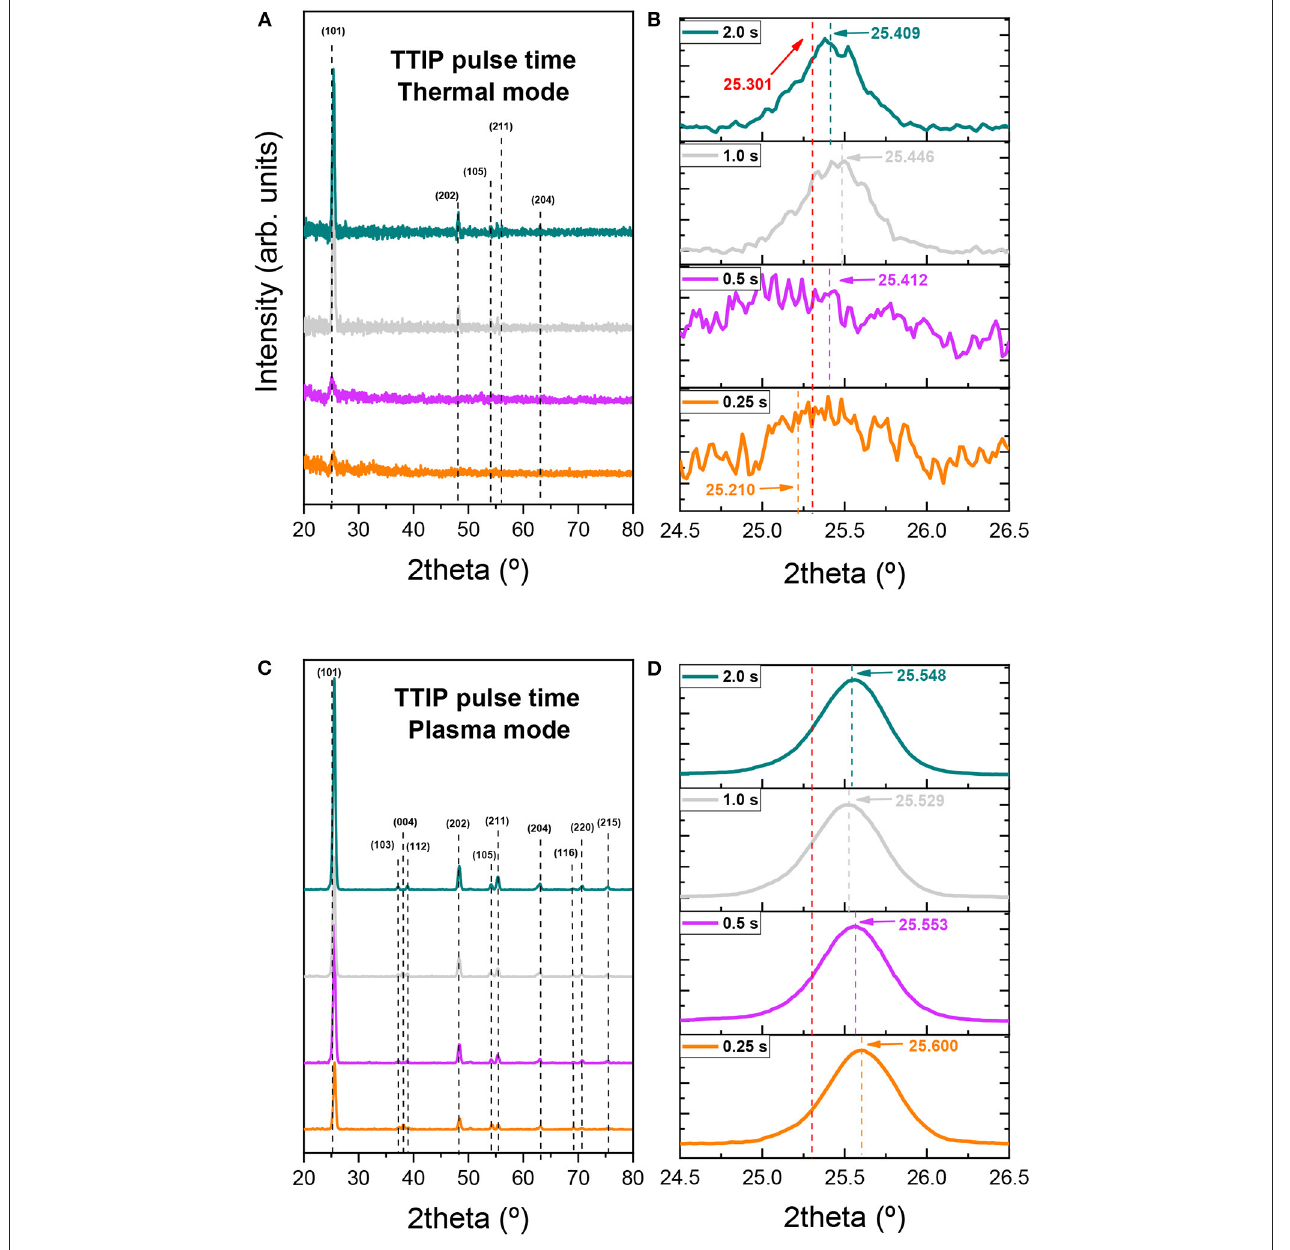
FIGURE 8 | GIXRD diffractogram for TiO 2 film growth using TTIP precursor: (A) third set of samples, (B) peak (101) for the third set of samples, (C) sixth set of samples, and (D) peak (101) for the sixth set of samples.